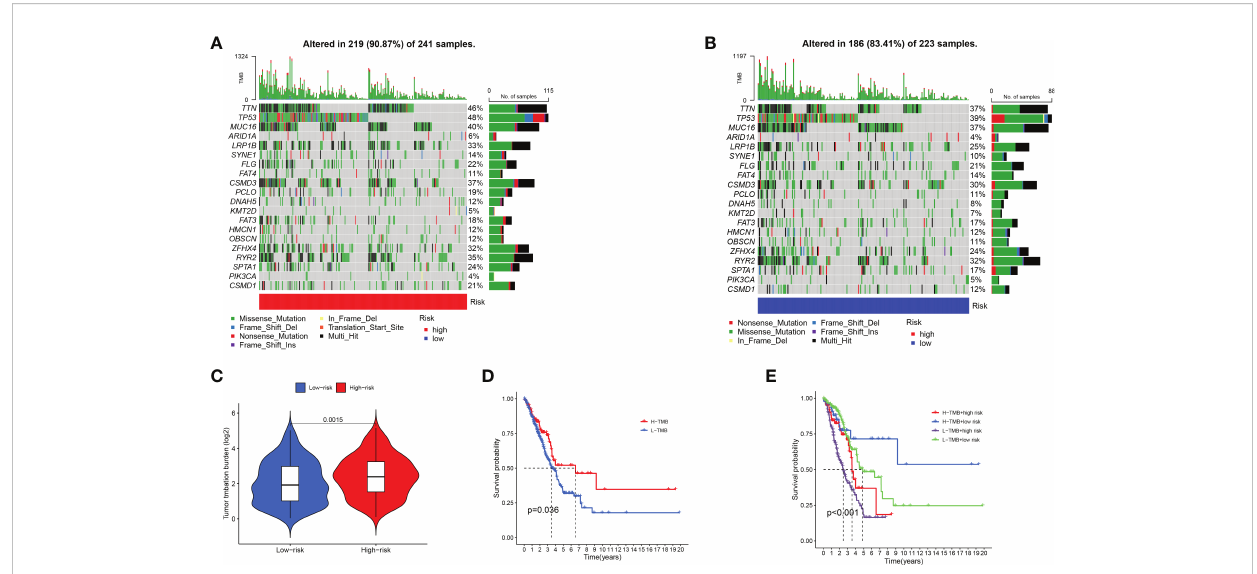
FIGURE 7 Impact of risk score models on somatic gene alterations and TMB. (A, B) Comparison of gene mutation rates between two subgroups. (C) Differential analysis of TMB between two subgroups. (D) The prognostic role of TMB in LUAD patients. (E) The prognostic role of combined risk score model and TMB in LUAD patients.